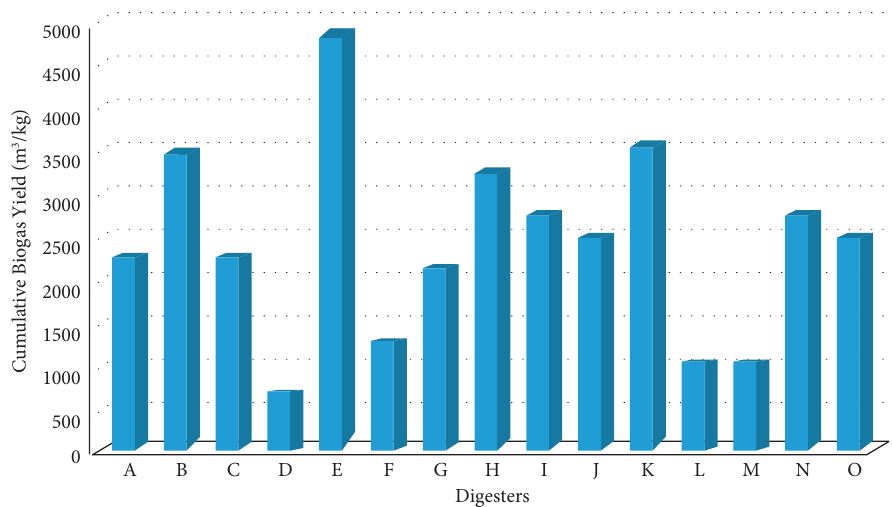
Figure 3: Cumulative (40days) biogas production for each of the digesters